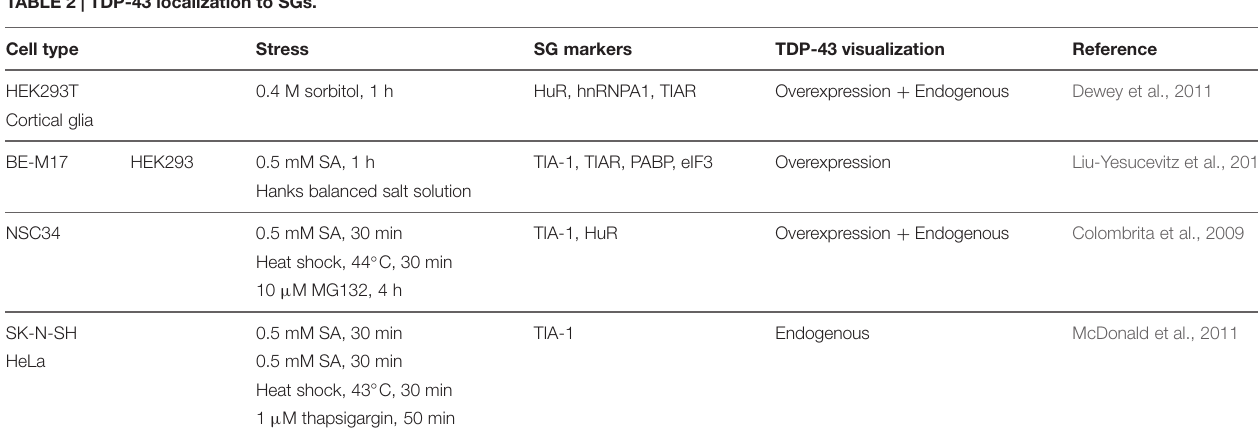
TABLE 2 | TDP-43 localization to